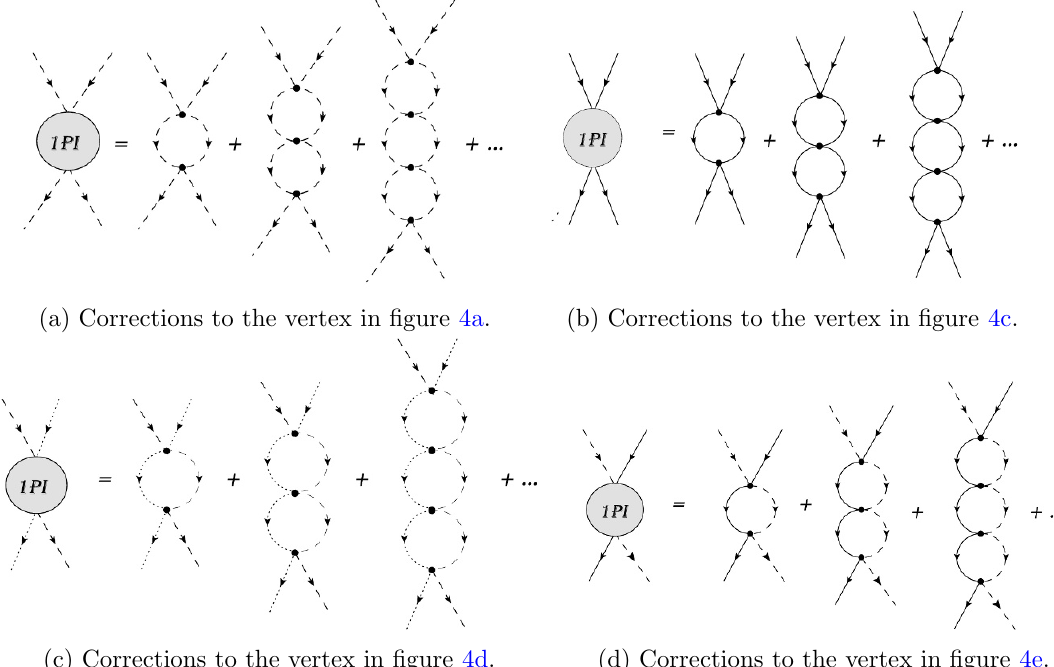
Figure 2. Quantum corrections to the vertices of the model (4.3). Dashed long spaced lines (as in (cid:12)gure 4a) denote the bosons (cid:30) 1 , dotted lines (as in (cid:12)gure 4a) denote the bosons (cid:30) 2 . Solid lines (as in (cid:12)gure 4c) denote fermions. Note that the corrections to the vertex in (cid:12)gure 4b are of the same form described in (cid:12)gure 2a, but with all lines replaced by dotted lines (that represent (cid:30) 2 ). Similarly, the corrections to the vertex in 4d are of the same form described in (cid:12)gure 2d with all bosonic lines of (cid:30) 1 replaced by lines of (cid:30) 2 . For each diagram there is an identical one where the vertex factor iq is replaced by i(cid:14) q